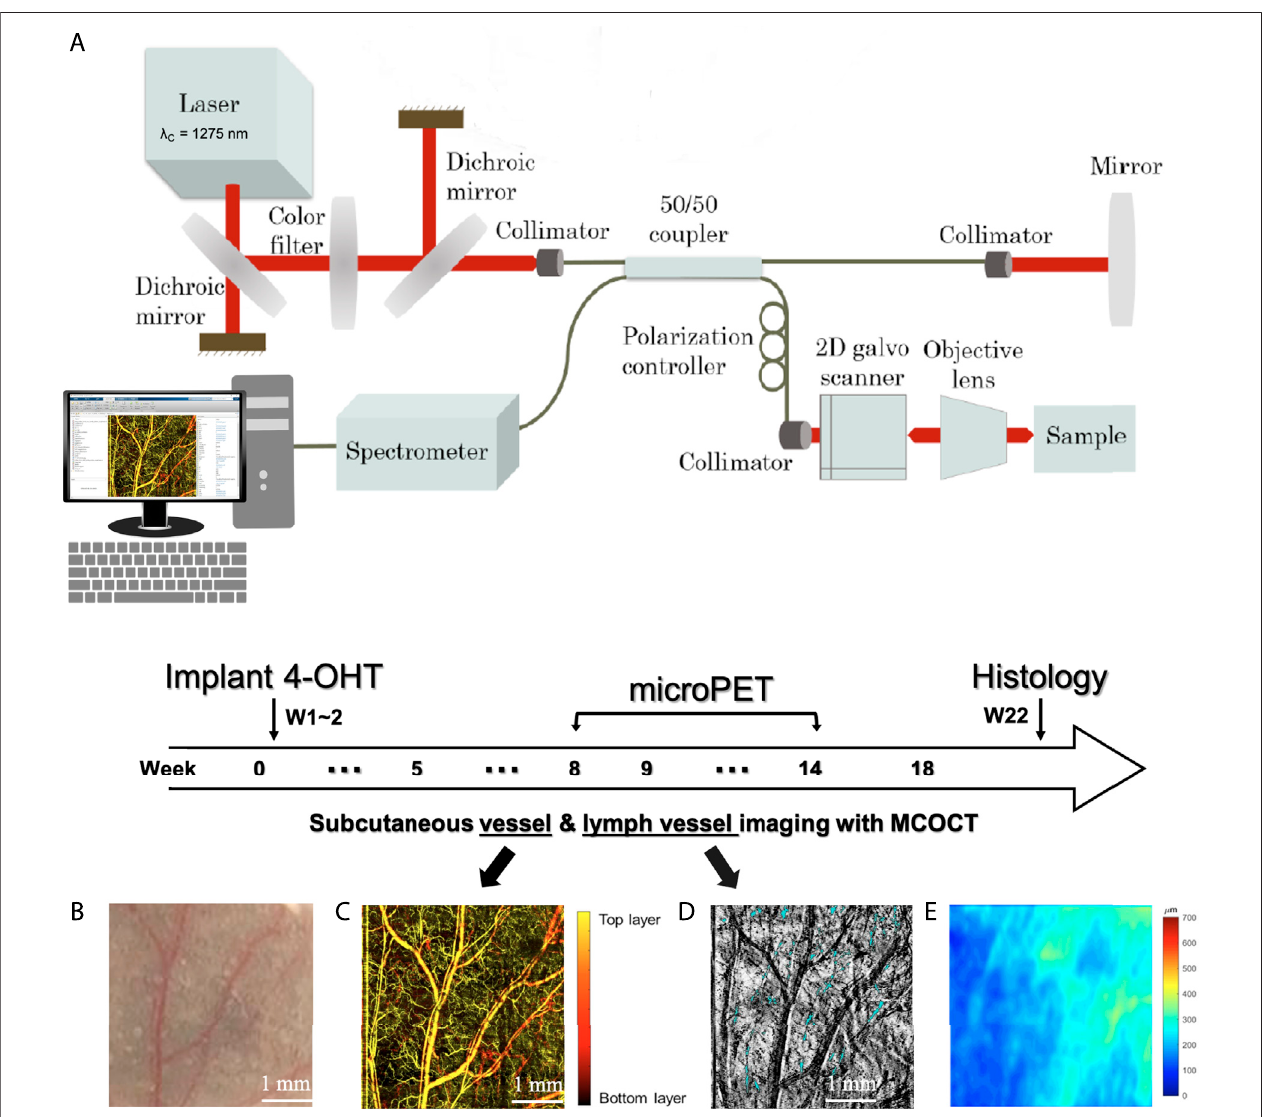
FIGURE 1 | (A) Schematic diagram of MCOCT system. Within 0 – 18 weeks of the experimental period, (B) skin appearance, (C) subcutaneous vessels, (D) OCT maximum intensity projection (MIP) imaging, and (E) thickness map were taken.